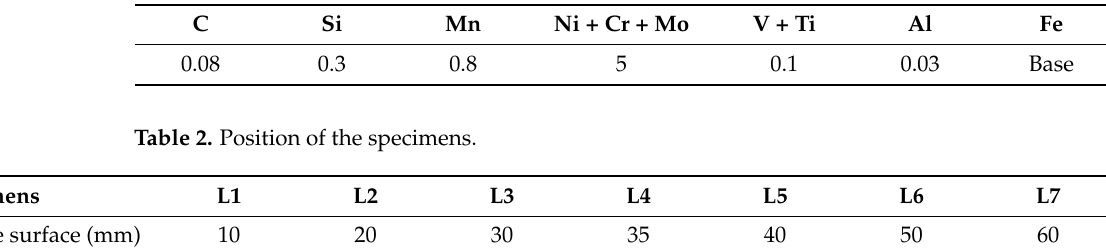
Table 1. Chemical composition of the steel (wt%).